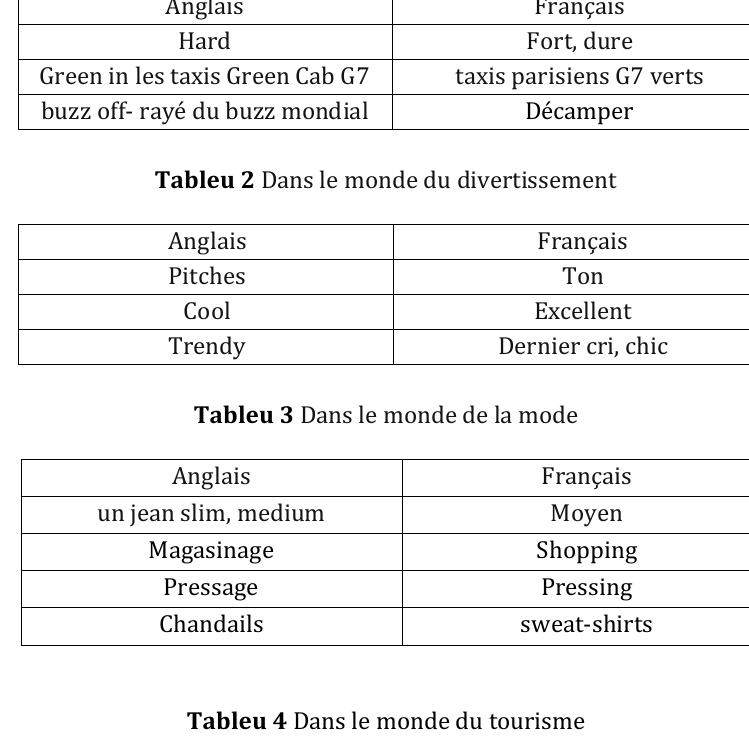
Tableu 4 Dans le monde du